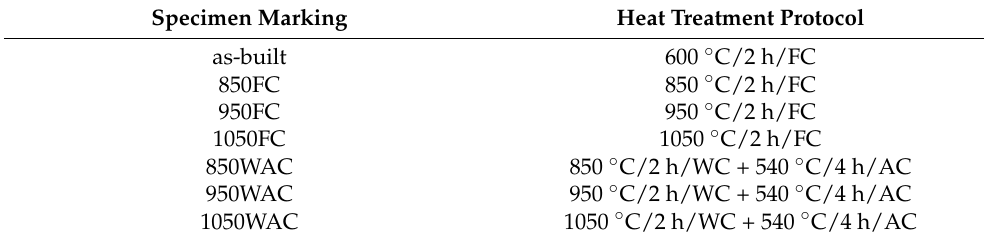
Table 2. The specific heat treatment protocols and markings.